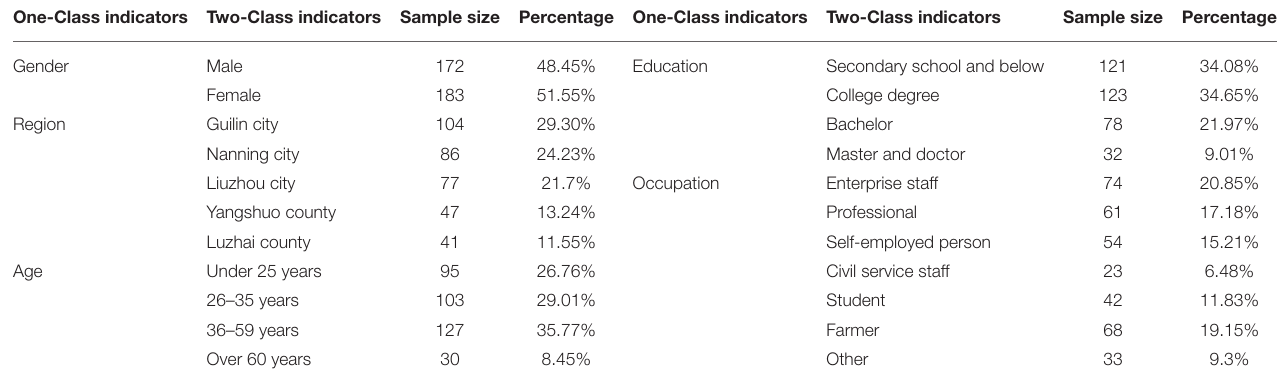
TABLE 1 | Sample distribution.